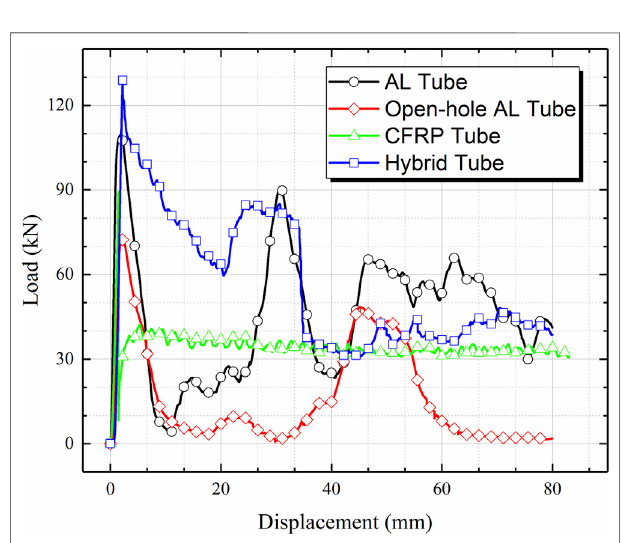
FIGURE 6 | (A) Load-displacement curve with deformation modes of hybrid tube, (B) Vertical view of the crushed hybrid tube, and (C) Pro fi le view.